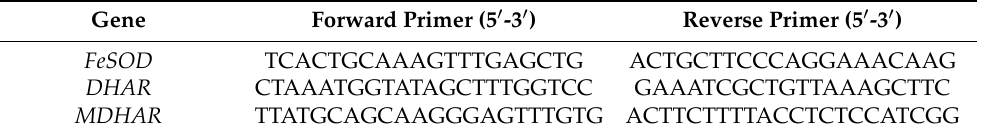
Primer sequences used in the cDNA cloning of white clover FeSOD , DHAR and MDHAR genes.